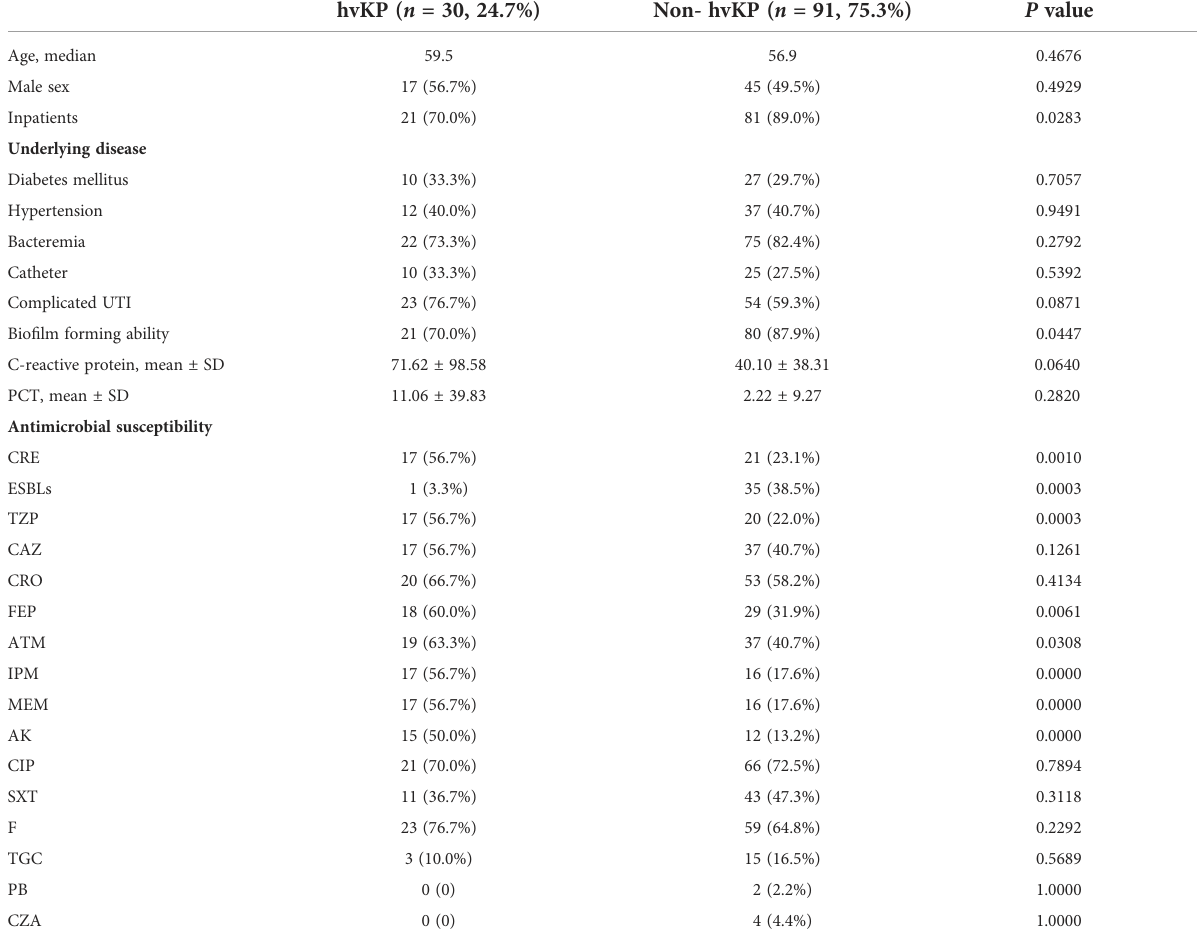
TABLE 1 Clinical characteristics and susceptibility of hvKP and cKP